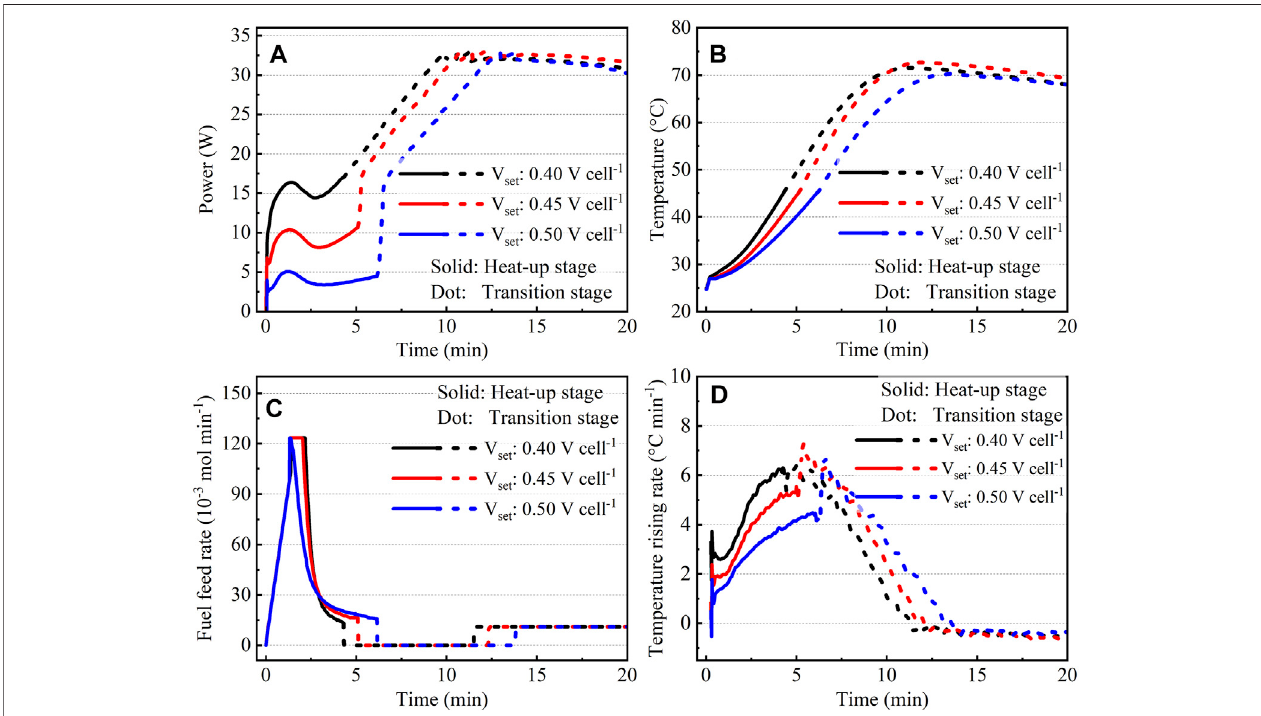
FIGURE 7 | Pro fi les of the (A) power, (B) temperature, (C) fuel feed rate, and (D) temperature rising rate of the DMFC during startups at various V set . C ini : 0.3 mol L − 1 ; T ini : 23 ° C; Δ I set : 0.5 A.